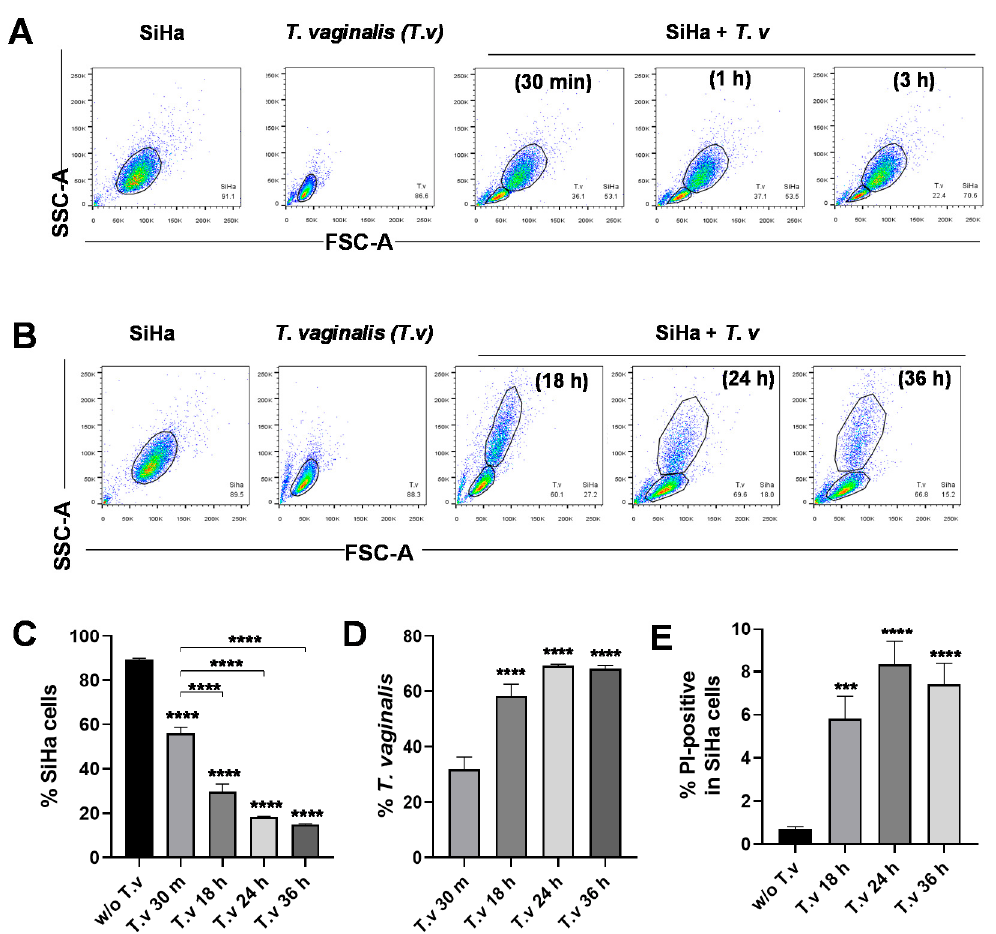
Figure 1. Flow cytometric analysis of parasite–host cell mixed culture. ( A , B ) SiHa cells were infected with live T. vaginalis (T.v) trophozoites for the indicated durations. Cells were then trypsinized and analyzed by flow cytometry. Flow cytometry data plots based on cell size (SSC-A and FSC-A) were used to identify T. vaginalis (small) and SiHa (large) cell populations. ( C ) SiHa cell levels were quantified from flow cytometry data ( n = 3). ( D ) Bound T. vaginalis levels were quantified from flow cytometry data ( n = 3). ( E ) Propidium iodide (PI) positive ( + ) dead SiHa cells at the time indicated ( n = 3).